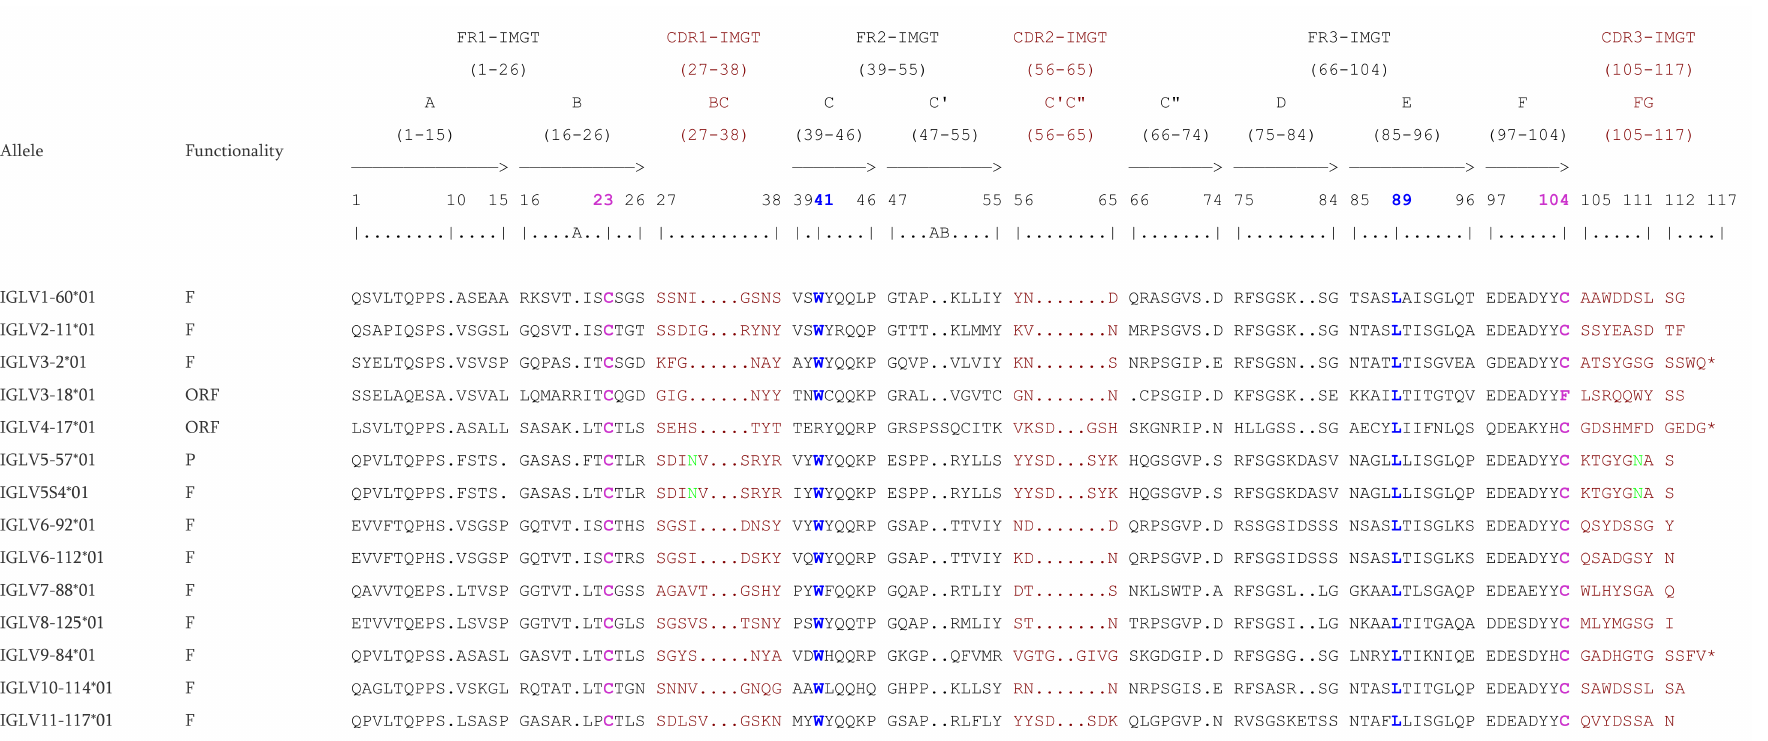
Figure 6. IMGT Protein display of the Macaca mulatta (rhesus monkey) IGLV genes. Only a few functional genes, ORF and in-frame P are shown, as examples. The outline of the CDR-IMGT and FR-IMGT are according to the IMGT unique numbering for V-REGION [70]. The four conserved amino acids are shaded in pink for the C23 and C104, blue for the W41 and hydrophobic AA 89. * indicates in frame STOP-CODON. The CDR-IMGT are shaded in maroon while the FR-IMGT are in black. Data available in IMGT Repertoire (IG and TR) http://www.imgt.org/IMGTrepertoire/, accessed on 11 November 2021 > Proteins and alleles > Protein displays > V-DOMAIN > IGLV > Rhesus monkey ( Macaca mulatta ) or IMGT DomainDisplay http://www.imgt.org/3Dstructure-DB/cgi/DomainDisplay.cgi, accessed on 11 November